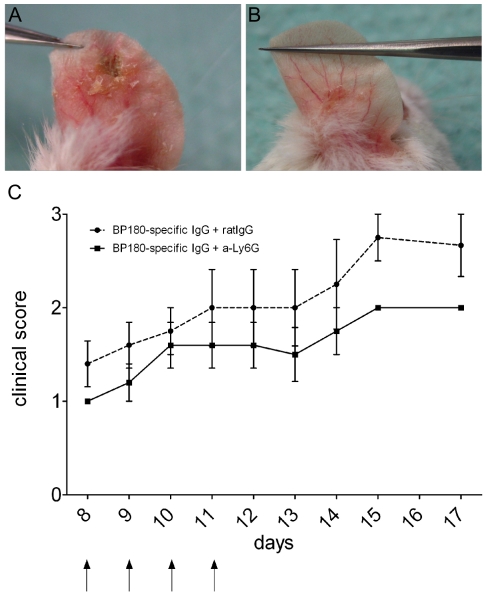
Neutrophil depletion partly inhibits skin blistering induced by BP180/CXVII-specific IgG in mice.Mice pre-immunized with rabbit IgG and injected i.p. with BP180/CXVII-specific rabbit IgG were treated with (A) a Ly-6G-specific monoclonal or (B) a mock antibody as described in Materials and Methods (arrows). (C) Disease activity during the depletion of Ly-6G-positive cells is significantly reduced in the group of mice treated with Ly-6G-specific antibody (n = 5) compared with the group treated with mock antibody (n = 5; p<0.05). Data are shown as mean ± SD.